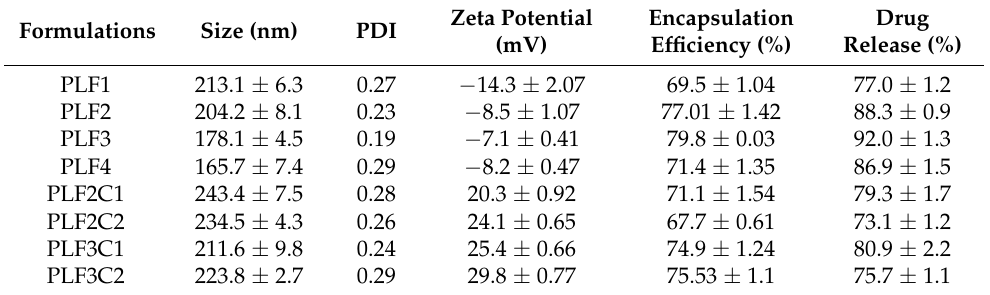
Table 2. Physicochemical characterization of piperine-loaded uncoated and chitosan-coated lipo- somes. The study was performed in triplicate ( n = 3), and data are shown as mean ± SD.